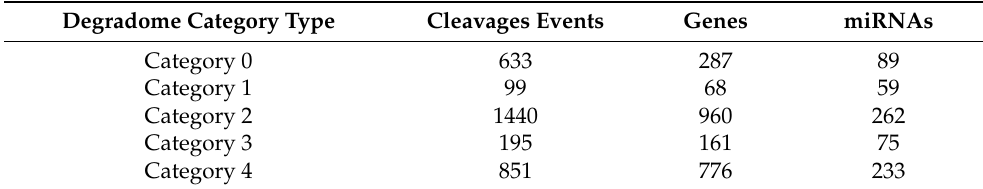
Figure 8. Analysis of known miRNA targets by degradome sequencing and statistics for miRNA targets. (A ) Venn diagram of differentially expressed target genes in stages 6 and 7 of PA64S(S) and PA64S(F). ( B ) Targets of osa-miR156a. ( C ) Targets of osa-miR5488. ( D ) Targets of osa-miR399d. Red lines indicate the signature produced by miRNA-directed cleavage. Table 3. Categories of candidate cleaved sites by degradome